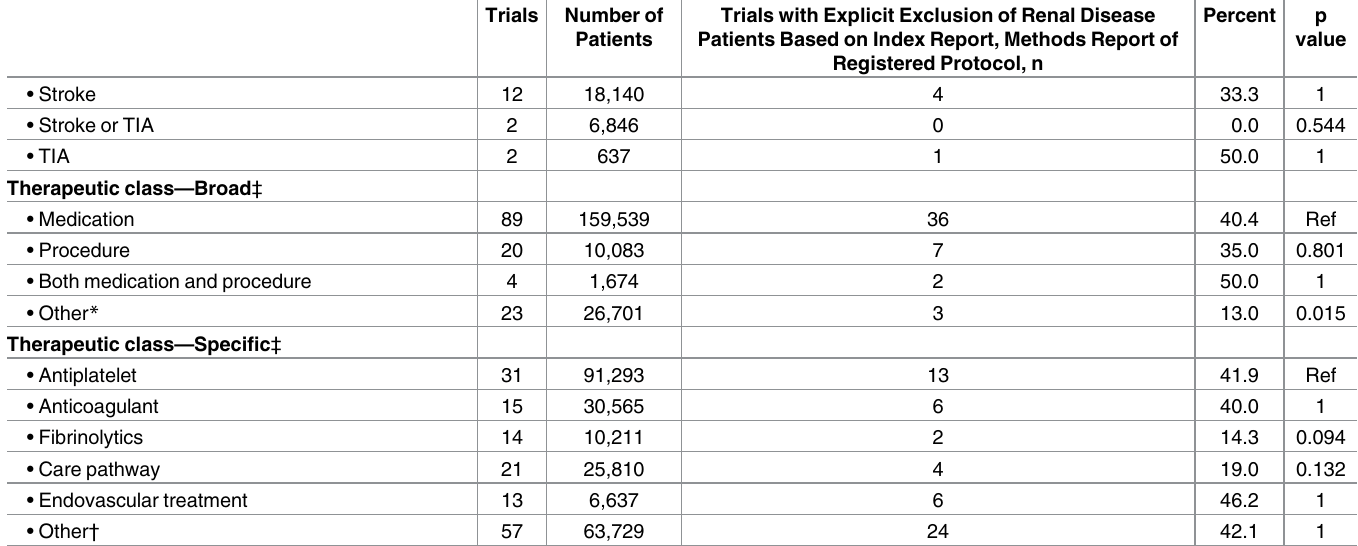
form and 19 (39.6%) used nonspecific qualitative exclusion criteria (such as “significant renal impairment,” “nephropathy,” “renal dysfunction,” and “severe renal insufficiency”). No trial reported that patients with specific degrees of KD severity were recruited.